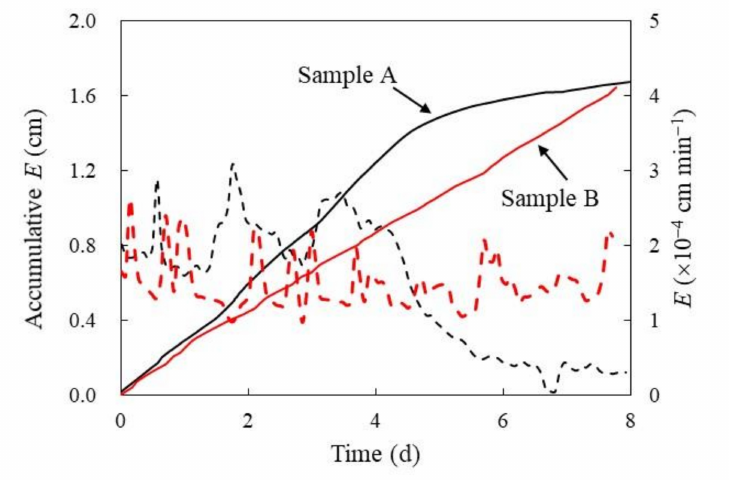
Figure 7. Time series of the measured evaporation rate (dashed lines) and cumulative evaporation (solid lines) in two real evaporation